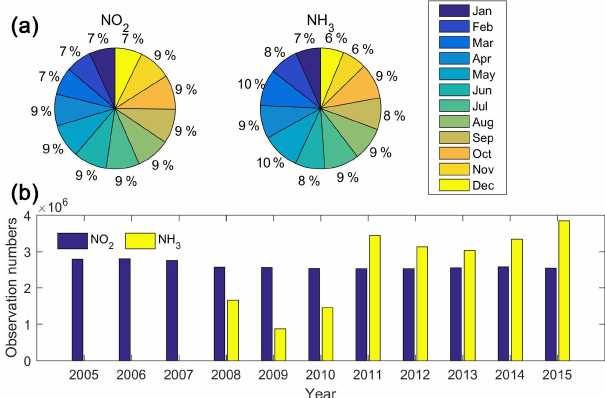
Figure 1. The satellite-derived observation numbers for NO 2 and NH 3 . Panel (a) shows the percentages of observations in each month in 2010 for NO 2 and in 2015 for NH 3 and (b) represents the total observation numbers for NO 2 and NH 3 over China. No- tably, the NO 2 observation numbers were gained from DOMINO products with a cloud radiance fraction below 0.5, while the IASI observations with a relative error below 100% or an absolute er- ror below 5 × 10 15 moleccm − 2 were processed for analysis over